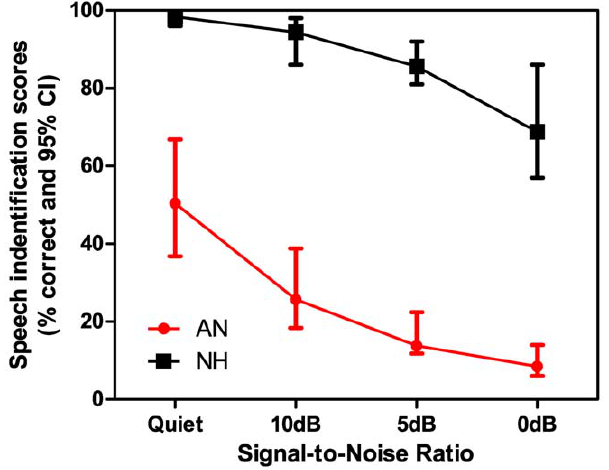
Figure 3. Speech identification scores as a function of signal to noise ratio for listeners with normal hearing (open circle) and those with AN (filled square). The error indicates 95% confidence